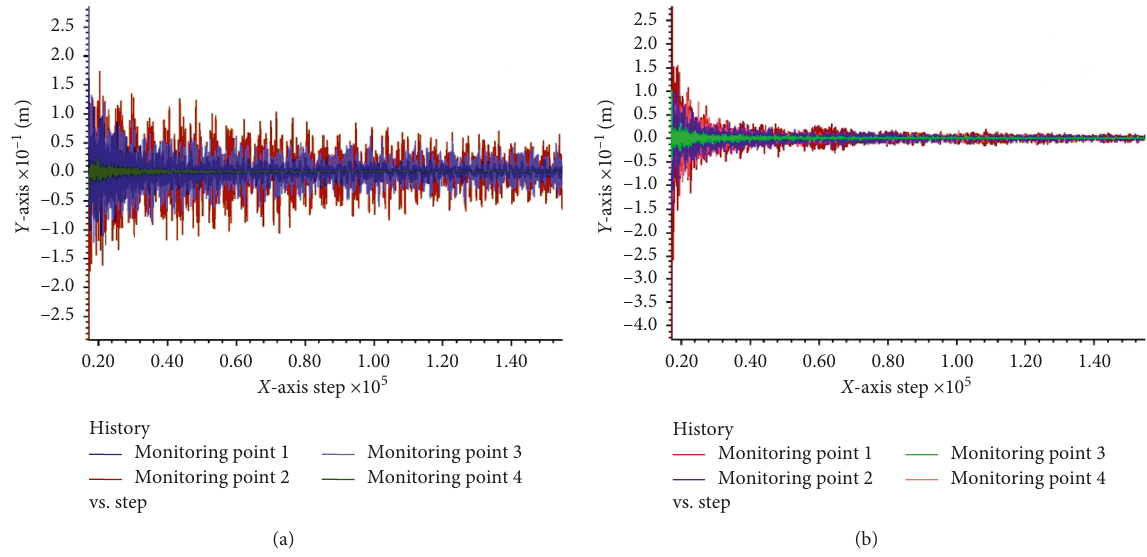
Figure 10: Deformation velocity response diagrams for ten dynamic loads. (a) X -directional deformation velocity and (b) Z -directional deformation